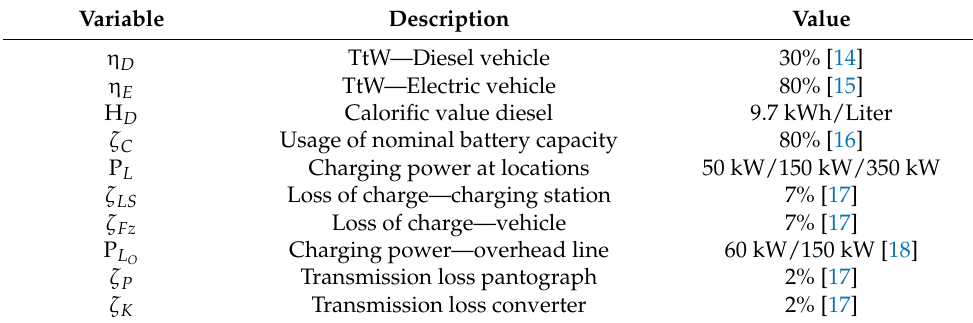
Table 1. Data basis for calculations (own